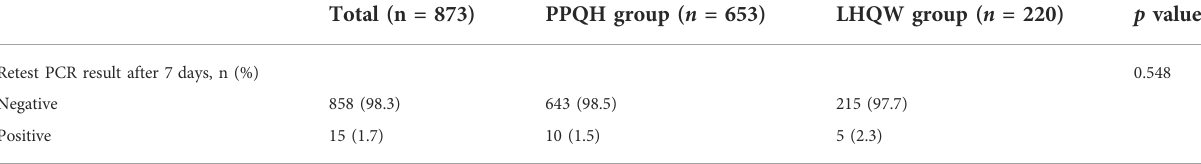
TABLE 6 Comparison of the re-positive rate between the two groups of SARS-CoV-2-infected